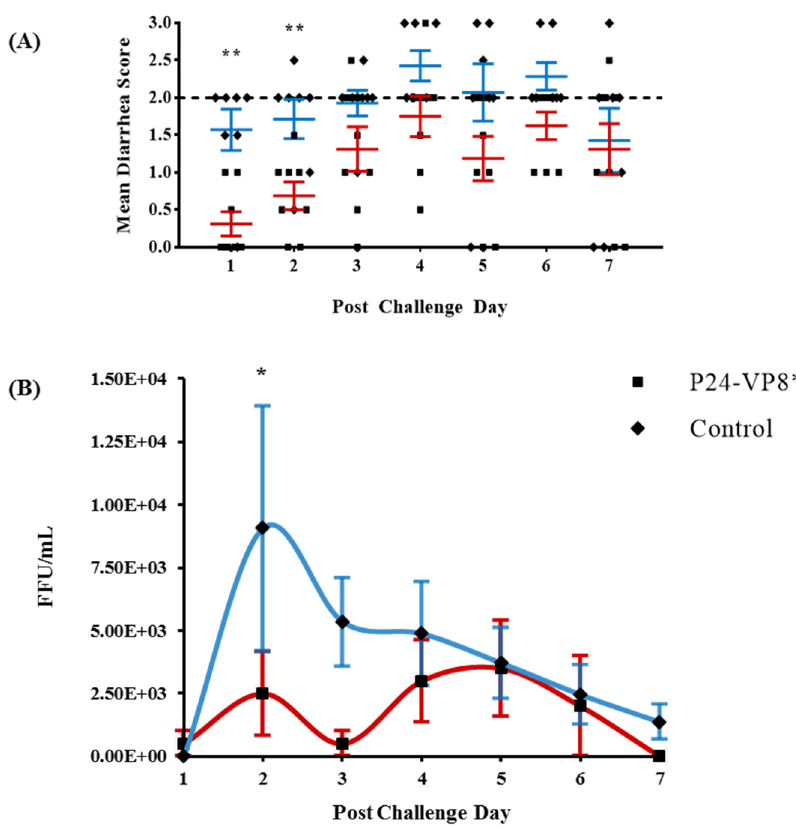
Figure 1. P24-VP8* vaccine protected against VirHRV diarrhea and reduced overall virus shed among vaccinated pigs. Fecal consistency ( A ) and virus shedding ( B ) were monitored daily from post challenge day (PCD) 1 to PCD 7 after the challenge with VirHRV. Fecal consistency scores ≥ 2 were considered to be diarrheic (dashed line indicates the threshold of diarrhea). Statistical significance between vaccinated and control groups, determined by multiple t tests, are indicated by asterisks (*, p < 0.05; **, p < 0.01).